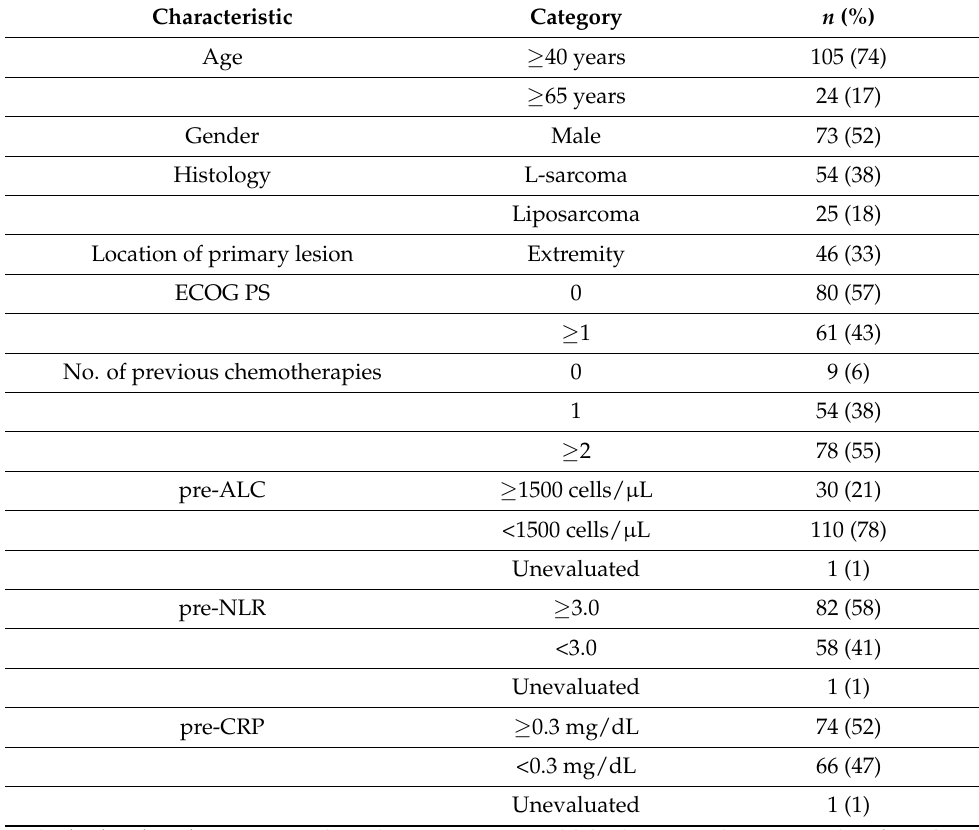
Table 1. Baseline characteristics of the study patients ( n = 141).